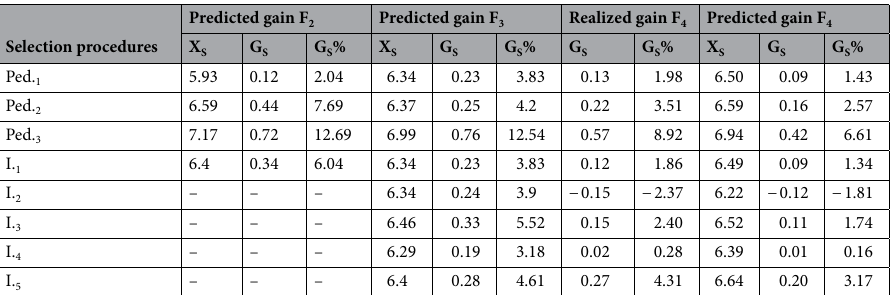
Table 3. Predicted and realized gains from the different selection procedures for yield and yield components in the three segregating generations. a The simple correlation between predicted and realized gains = 0.847**. b The simple correlation between predicted and realized gains = 0.769*. c The simple correlation between predicted and realized gains = 0.434 ns. d The simple correlation between predicted and realized gains = 0.667 ns. e The simple correlation between predicted and realized gains = − 0.800*. f The simple correlation between predicted and realized gains = 0.813*. g The simple correlation between predicted and realized gains =